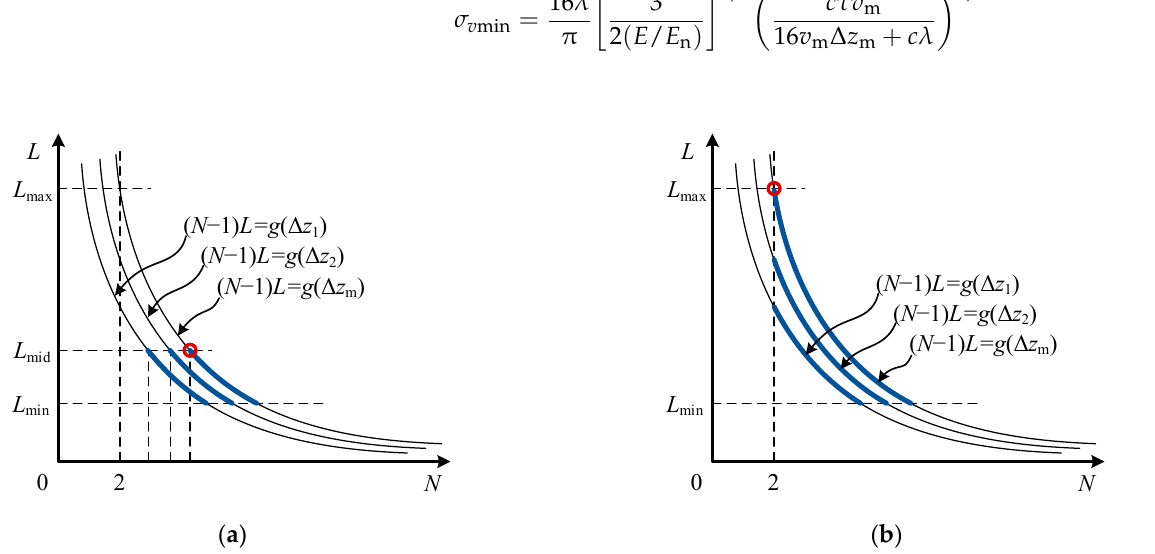
Figure 4. Feasible region of cost function of velocity estimation accuracy: ( a ) the case of v m Δ z m ≥ c λ /16; ( b ) the case of v m Δ z m < c λ /16.